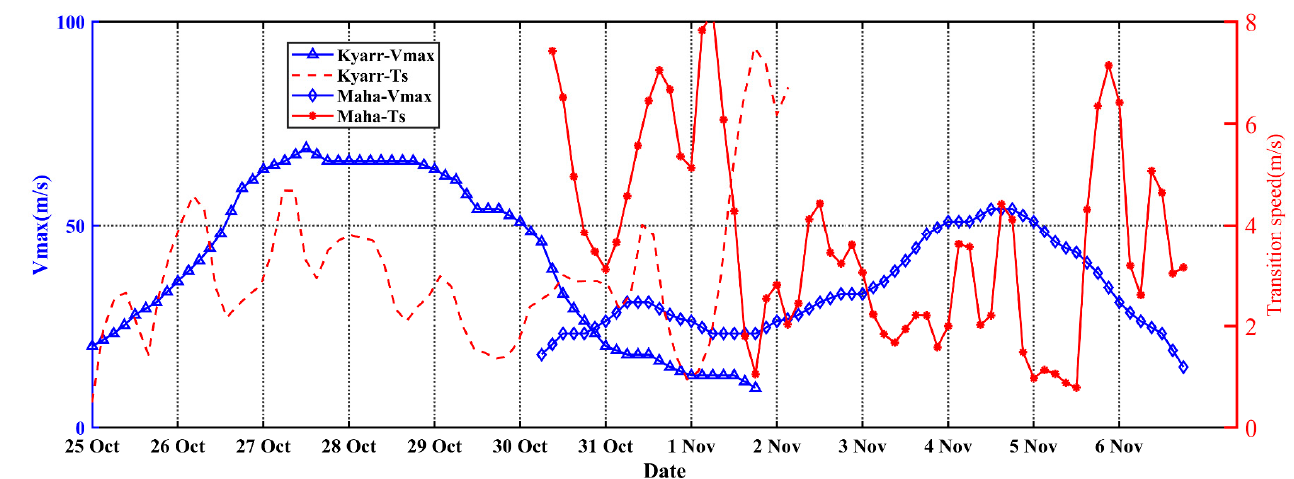
Figure 2. Translation speed and maximum wind speed of TCs Kyarr and Maha.